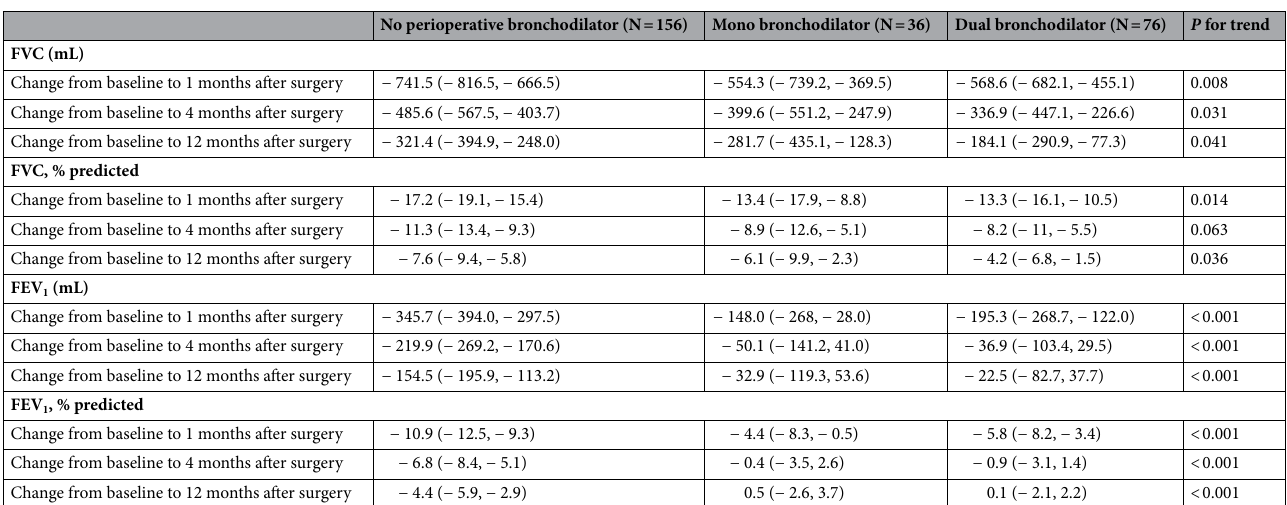
Table 3. Changes in pulmonary function from baseline to 1, 4, and 12 months following lung resection between mono and dual bronchodilators. ICS was not regarded as a bronchodilator therapy. Thus, 36 (32.1%) including ICS/LABA were categorized into mono bronchodilator therapy with either LAMA or LABA, and 76 (67.9%) including ICS/LAMA/LABA were categorized into dual bronchodilator therapy with both LAMA and LABA. Adjusted for age, sex, body mass index (underweight, normal, overweight, or obese), smoking status (never, past, or current), surgical extent (limited resection, lobectomy, bilobectomy, or pneumonectomy), VATS, and preoperative baseline FEV 1